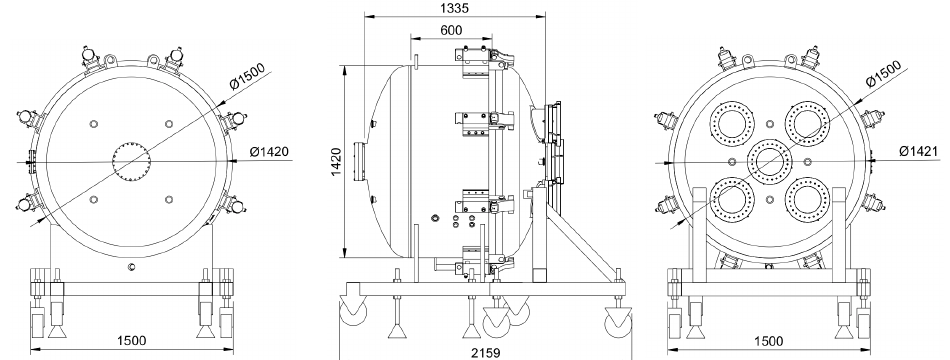
Figure 3. Schematic drawings of the pressure vessel: end view of the back side ( left ), side view with the vessel door to the right ( middle ), and end view of the door side ( right